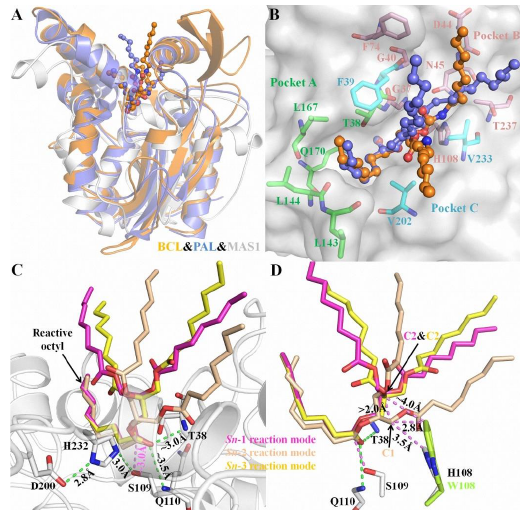
Figure 1. The characteristics of substrate binding with MAS1 in different reaction modes. ( A ) The structural superimposition of BCL (orange), PAL (blue) and MAS1 (white). ( B ) The catalytic pockets of MAS1. The TC analogue from BCL and PAL were showed as orange and blue ball-and-stick, respectively. The comprising residues of pocket A, B and C were showed as green, pink and cyan sticks, respectively. ( C ) The binding conformation of TC in different reaction modes. ( D ) The struc- tural alignment of MAS1 (white) and mutant H108W (lemon). H-bond distances and distances be- tween two atoms were presented as green and pink dashes, respectively. 2.2. Comparison of Different Reaction Conformations of TC Due to the prochirality of TAG, three isomeric DAGs could be produced in its deac- ylation processes. Therefore, in theory, there are three different reaction modes of TAG during its lipase-catalyzed deacylation. To gain some insights into the molecular basis of the regiospecificity of MAS1, the reaction conformations of TC in sn -1, sn -2 as well as sn - 3 reaction modes were manually built using the covalent binding tricaprylin (TC) ana- logue of PAL and BCL mentioned before as the templates (see Figure S3 for the atom numbering of TC in different conformations). Close inspection of the binding geometries between the substrate and MAS1 in all modes showed a similar position of the reactive octyl chains in pocket A (Figure 1C, the catalytic triad was formed by the hydrogen bond linked S109, H232 and D200). Moreover, in all modes, the distances between the nitrogen atoms in the main chain of T38 and Q110 (oxyanion hole) and the carbonyl oxygen of reactive octyl chains were ~3.0 Å and ~3.5 Å, respectively, and the distances between Oγ of the catalytic serine and their carbonyl carbon were ~3.0 Å. However, the non-reactive octyl chains accommodated by pocket B presented two types of configurations in three different modes. As shown in Figure 1D, the TC C1 in the sn -2 reaction mode was more than 2 Å below the TC C2 in the sn -1/3 reaction modes, indicating the glycerol backbone of TC in the former mode being closer to the bottom of the pocket B than that in the latter.